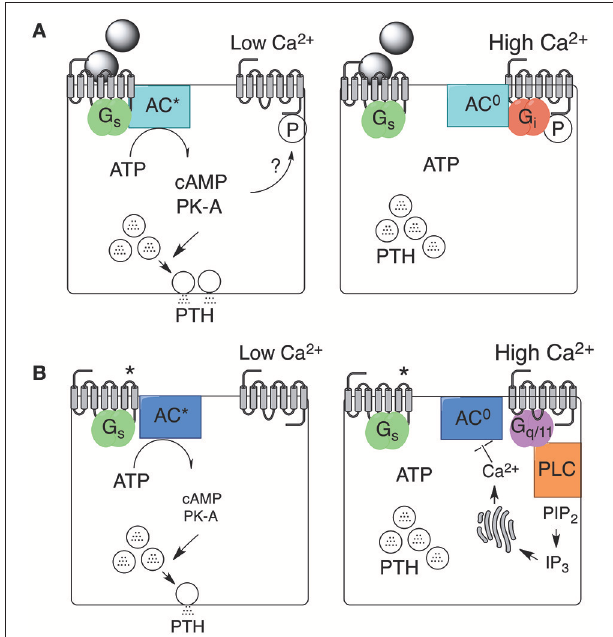
FIGURE 2 | Stimulated and spontaneous mechanisms in support of PTH secretion and its inhibition by high Ca 2 + o . PTH secretion and its inhibition by high Ca 2 + o arises from two distinct mechanisms. One mechanism is supported by exogenous agonists, including neurotransmitters or hormones, that activate G s -coupled GPCRs as shown in (A) (left and right). PTH secretion continues provided Ca 2 + o remains low but is promptly inhibited by G i -dependent inhibition of adenylate cyclase in the presence of high Ca 2 + o . The mechanism by which the Ca 2 + o sensor, now known to be the CaSR, preferentially binds to G i in this context is not known but might depend on local protein kinase-A (PK-A) activation. A second mechanism occurs spontaneously and may be supported by constitutive G s -coupled GPCR activity (as shown in B ; left and right) or by autocrine/paracrine production of receptor activators. PTH secretion via this second mechanism continues provided Ca 2 + o remains low but is inhibited by high Ca 2 + o -induced G q / 11 -dependent activation of intracellular Ca 2 + mobilization or Ca 2 + influx (not shown). One possible mechanism by which increased intracellular free Ca 2 + concentration (Ca 2 + i ) suppresses PTH secretion is shown via Ca 2 + i -dependent inhibition of adenylate cyclase. *Receptor activated in the absence of neuronal or hormonal